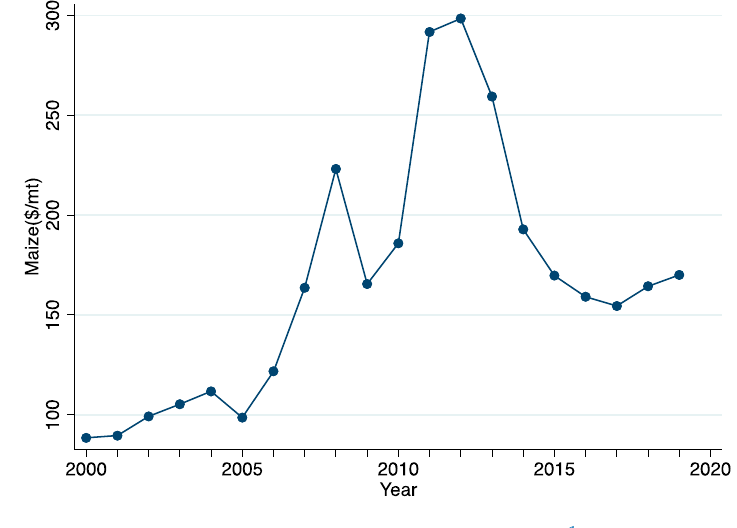
Figure 4. Global commodity prices for maize, 2000–2019 1